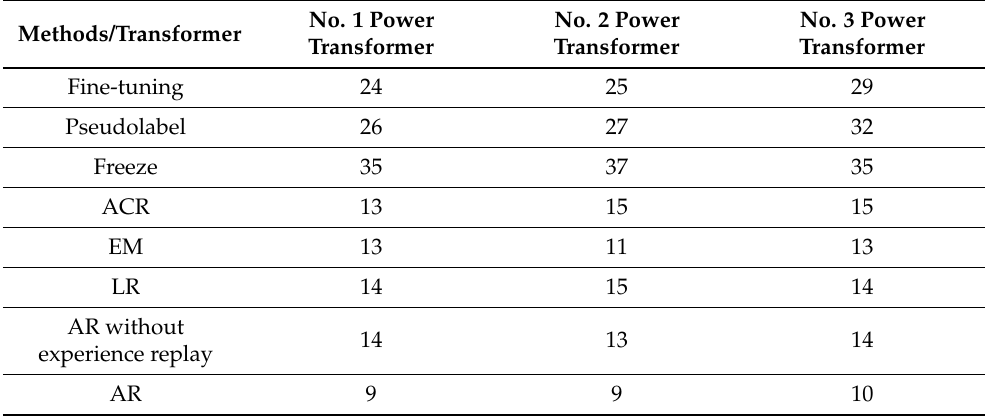
Table 3. Epochs required to achieve over 94% accuracy three times for each transfer learning method.